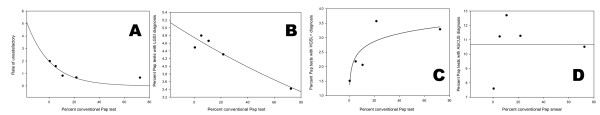
Changes in rates of diagnostic category in relation to the fraction of conventional Pap smear submitted to the Cytology Laboratory, University of Alabama Medical Center. a. Correlation between the unsatisfactory Pap test rate and the percentage of conventional Pap smear received in the last 5 years. b. Correlation between LGSIL rate and the percentage of conventional Pap smear received in the last 5 years. c. Correlation between HGSIL+ rate and the percentage of conventional Pap smear received in the last 5 years. d. Correlation between ASCUS rage and the percentage of conventional Pap smear received in the last 5 years.